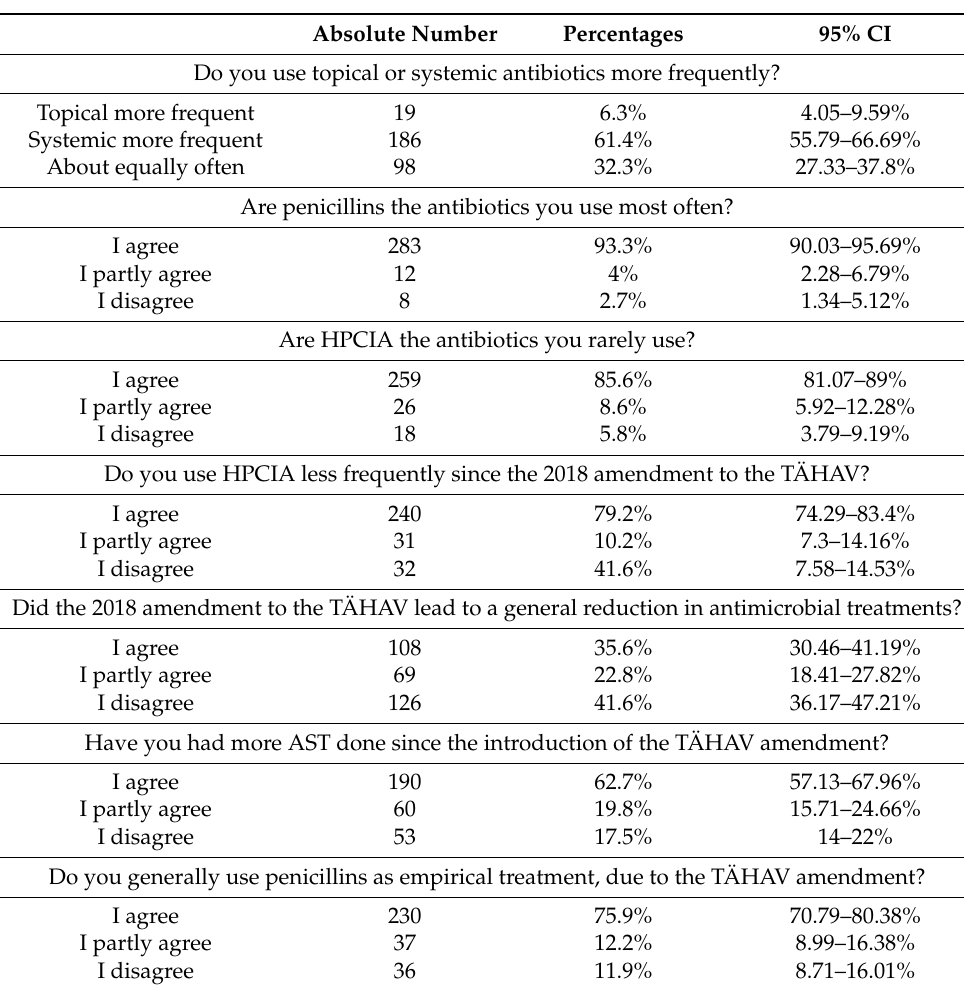
Table 1. Number, percentages, and 95% CI of responses to general antibiotic use as well as the impact of the TÄHAV amendment 2018 on the use of antimicrobials and AST. A total of 303 questionnaires of a survey among German veterinarians were